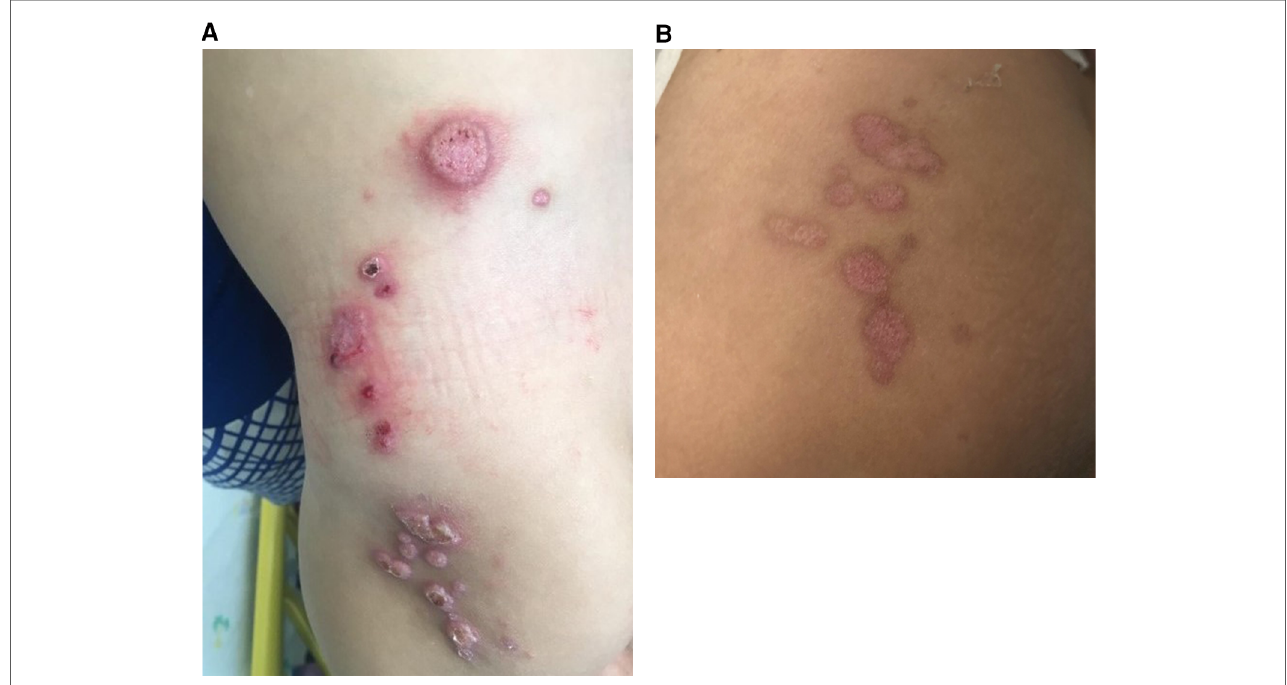
FIGURE 8 ( A ) Erythematous papulonodular eruption on the buttocks, lower back, and hip with scale and hemorrhagic crusts in a 10-month-old boy with X-linked CGD, consistent with molluscum contagiosum. (B) Post-treatment with IV cidofovir and a resolution of the lesions with the remaining postin fl ammatory changes and mild scarring. CGD, chronic granulomatous